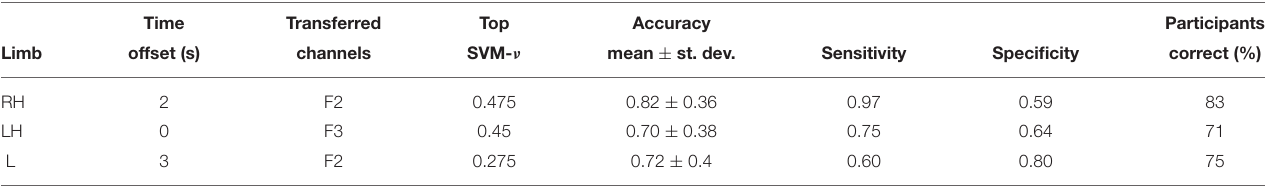
TABLE 3 | (Dataset 2) Classification performance on sPDP vs. sPNP using best-performing channels from (Dataset 1, cPWP vs. cPNP), evaluated separately on Right Hand (RH), Left Hand (LH), and Leg (L)